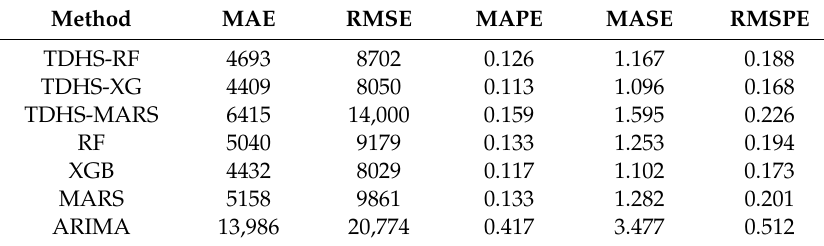
Table 2. Forecasting results of one step (week) ahead outpatient visits.